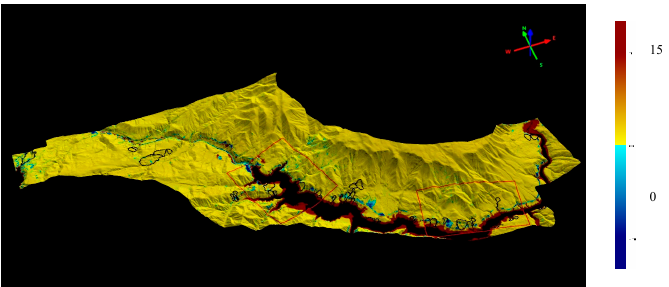
Figure 13. The residual plot of the Euclidian differences obtained from the comparison between 2012 and 2018 DTMs of the study area.